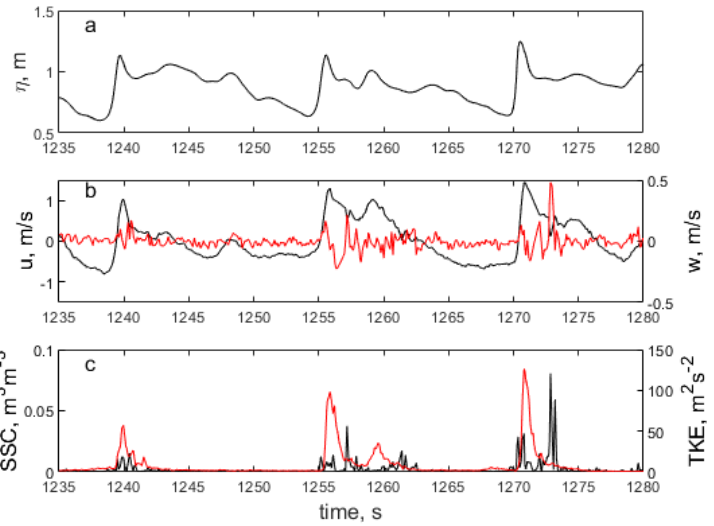
Figure 15. Time series of surface elevation ( a ), cross-shore ( u , black line) and vertical ( w , red line) velocity ( b ), and (panel ( c )) turbulent kinetic energy (TKE, black line) and suspended sediment concentration (SSC) at z = 3.5 cm (red line) for three plunging breakers at Durras Beach, NSW.